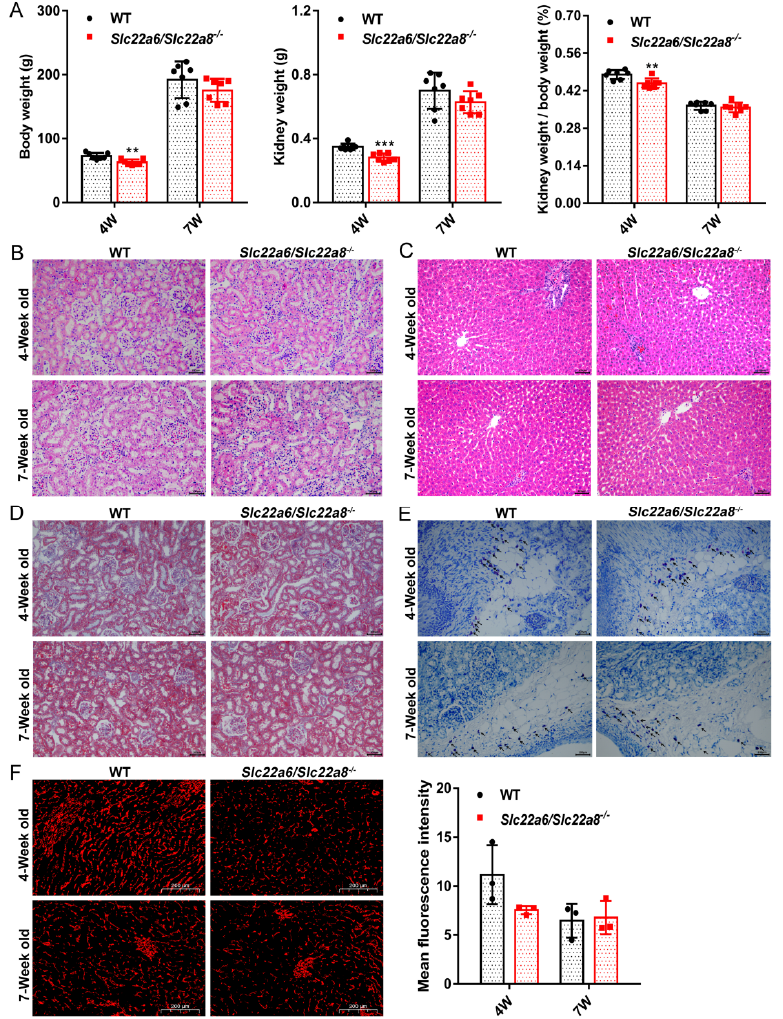
Figure 3. Effects of Slc22a6/Slc22a8 double-knockout on the body and kidney weights, physiological phenotype of the kidneys and livers in 4W and 7W WT and KO rats. ( A ) Body weight, kidney weight and kidney weight/body weight of 4W and 7W WT and KO rats (n = 7). ( B ) Hematoxylin and Eosin staining section of the kidneys in 4W and 7W WT and KO rats (200×) (n = 3). The cytoplasm was stained mauve by eosin and the cell nucleus was stained blue by hematoxylin. ( C ) Hematoxylin and Eosin staining section of the livers in 4W and 7W WT and KO rats (200×) (n = 3). ( D ) Masson staining section of the kidneys in 4W and 7W WT and KO rats (200×) (n = 3). The collagen fibers were stained blue. ( E ) Toluidine blue staining section of the kidneys in 4W and 7W WT and KO rats (200×) (n = 3). Mast cells were stained purple. Positive results are indicated by arrows. ( F ) Immunohistochemistry analysis of CD31 protein expression in the kidneys of 4W and 7W WT and KO rats (5×) (n = 3). The scale bar in picture B–E was 100 um in length and the picture F was 200 um. **, p < 0.01; ***, p < 0.001 compared with WT rats.